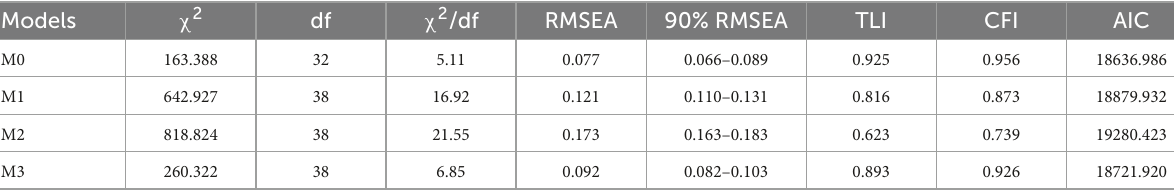
TABLE 3 The goodness-of-fit indexes of ESEM ( n =